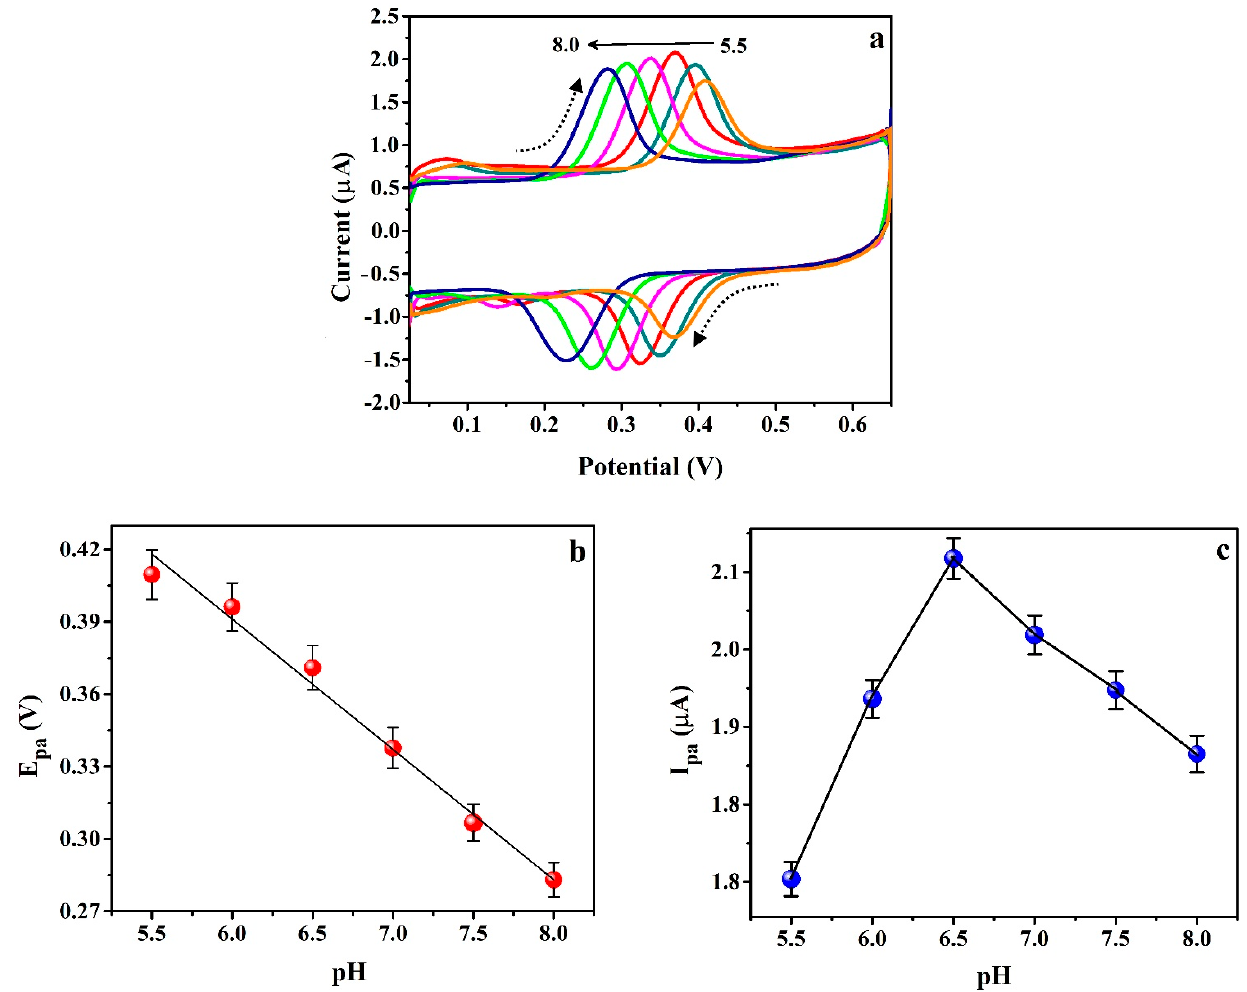
Figure 6. ( a ) Cyclic voltammograms for 0.01 mM ICN at the surface of P(PAN)LCNTPE in altered 0.2 M PB solution pHs ranging from 5.5 to 8.0 with the scan rate of 0.1 Vs − 1 . ( b ) Plot of E pa vs. pH. ( c ) Plot of I pa vs. pH.